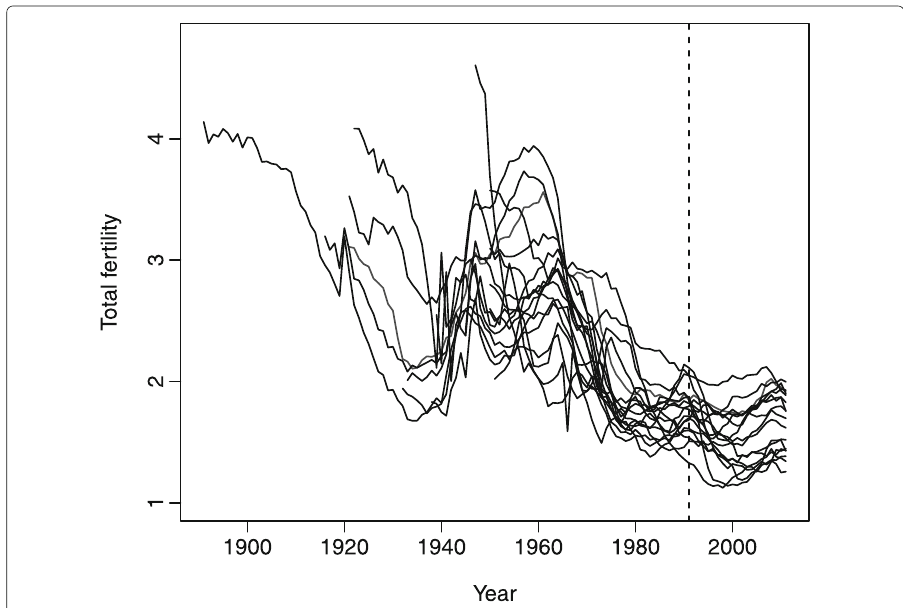
Fig. 1 Total fertility of 17 selected countries, where the vertical dotted line divides the in-sample period and the holdout sample